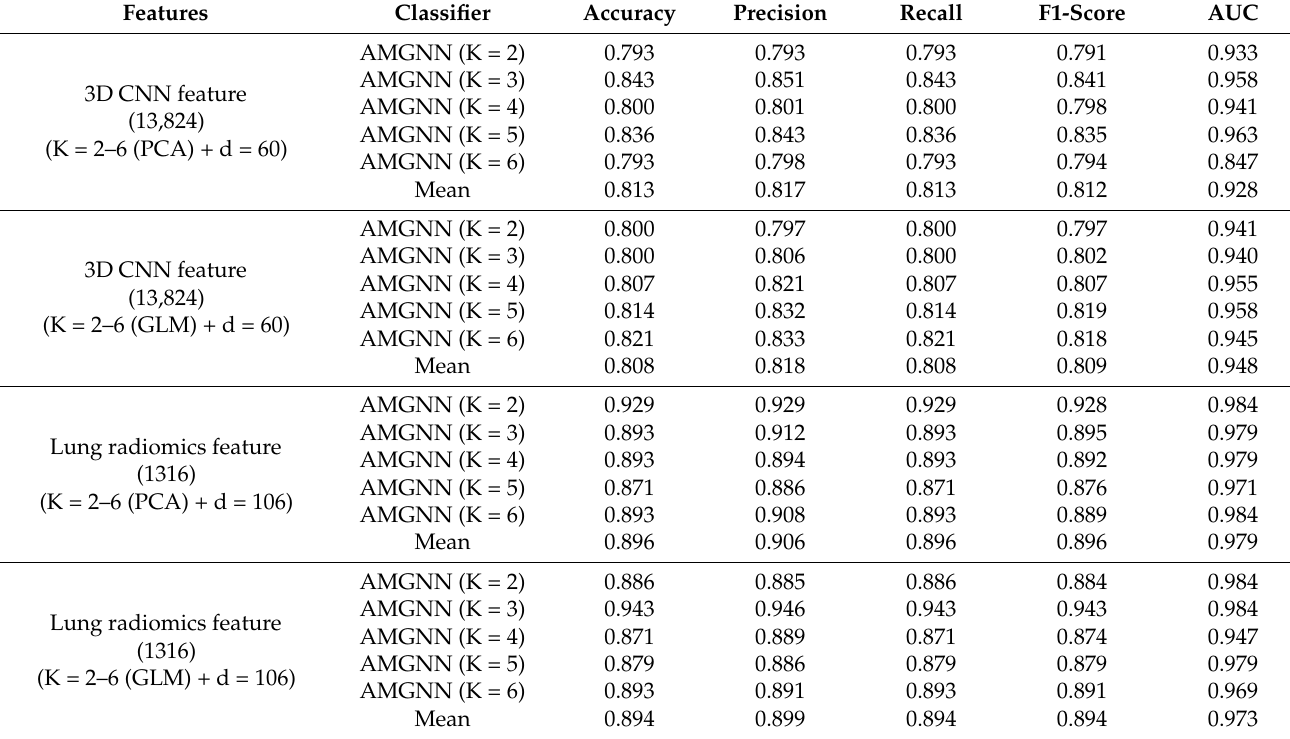
Table 10. The AMGNN classifier’s performance on the test set in Experiment